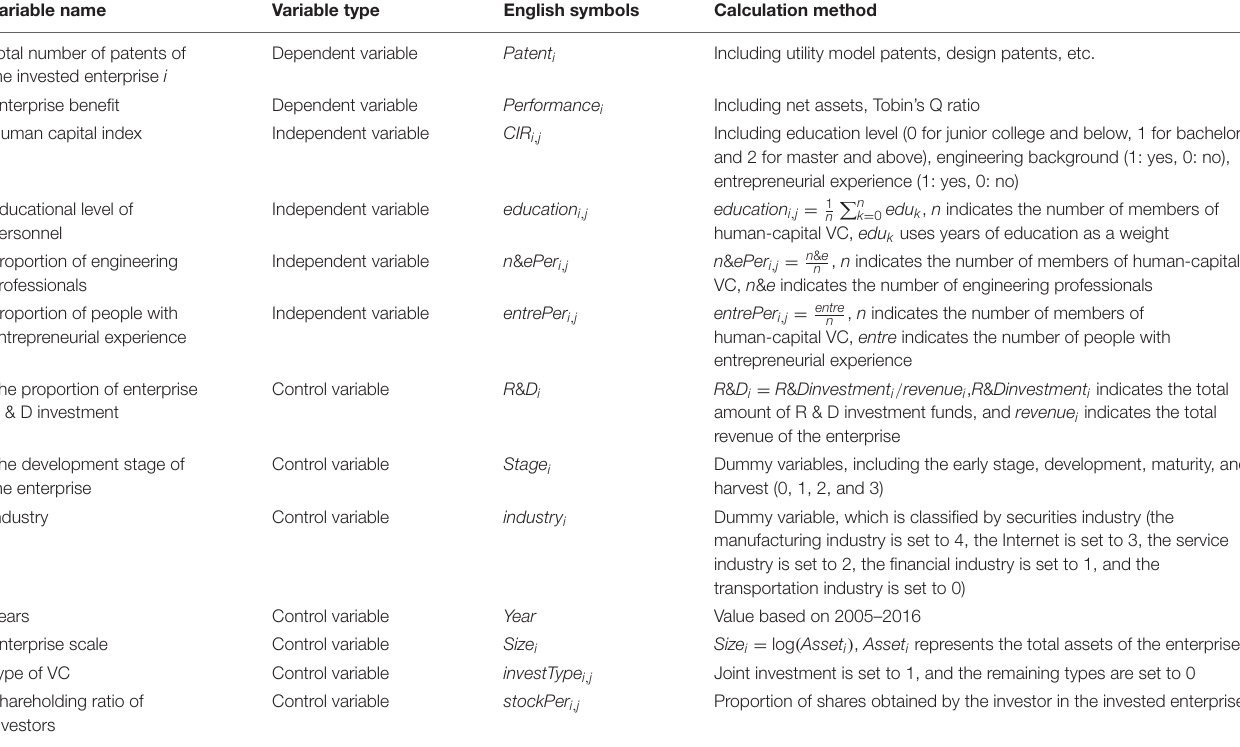
TABLE 1 | Introduction of each variable of the